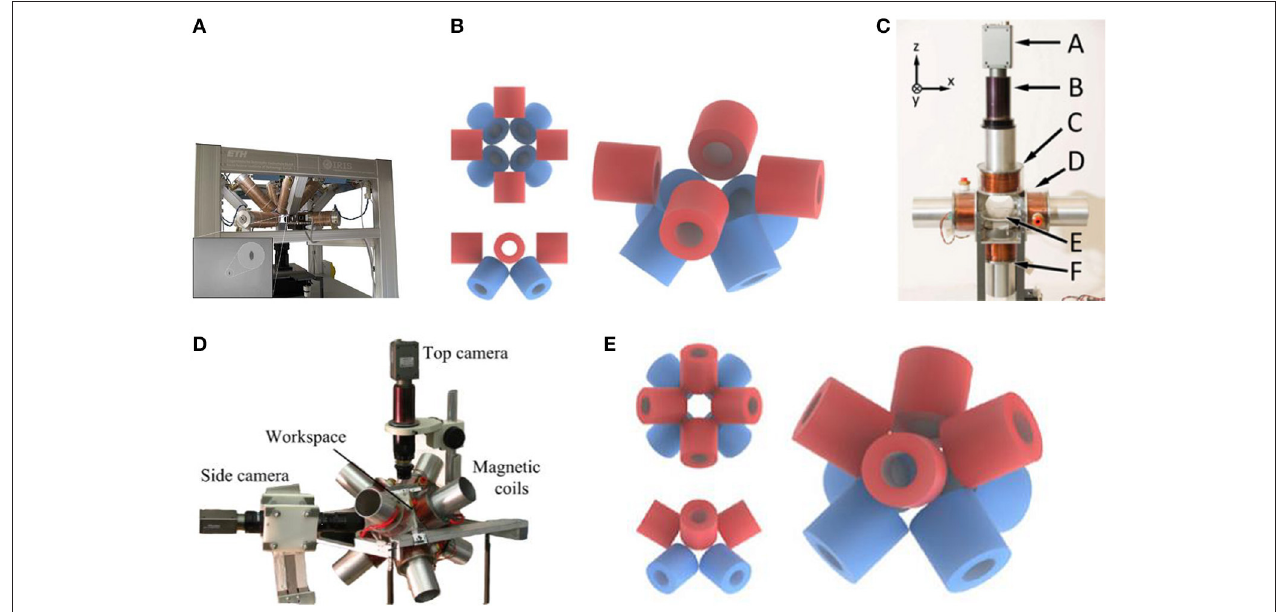
FIGURE 1 | (A) OctoMag control system has eight fixed electromagnetic coils for 5-DOF control (Kummer et al., 2010). (B) Model of electromagnetic coils configuration of OctoMag shows that the upper electromagnets have rotated 45 degrees relative to the lower electromagnets ( Pourkand and Abbott, 2018). (C) Six electromagnetic coils setup with a camera for top-view vision feedback and a microscope lens on the top for controlling Mag- µ Bots (Diller et al., 2012) (D) Eight electromagnetic coils system to control multiple micro-robots with different structures ( Diller et al., 2013) (E) Model of electromagnetic coils configuration shows that 8-electromagnetic coils are distributed diagonally (Pourkand and Abbott,